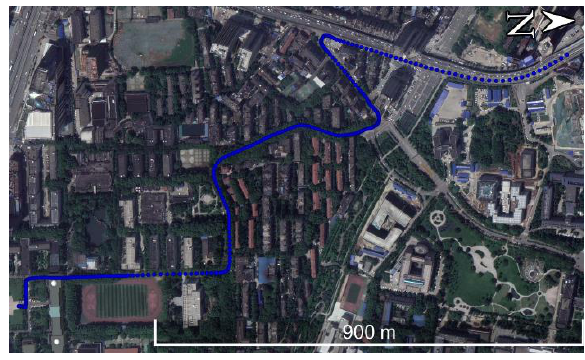
Figure 7. Test trajectory in the urban area.